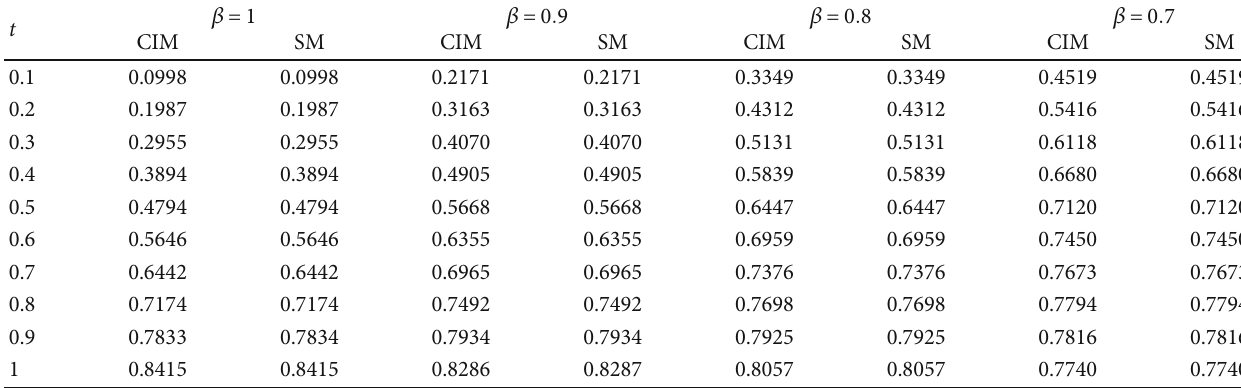
Table 1: The approximate solutions for various values of β and t ∈ ½ 0, 1 (cid:2) corresponding to Problem 1.